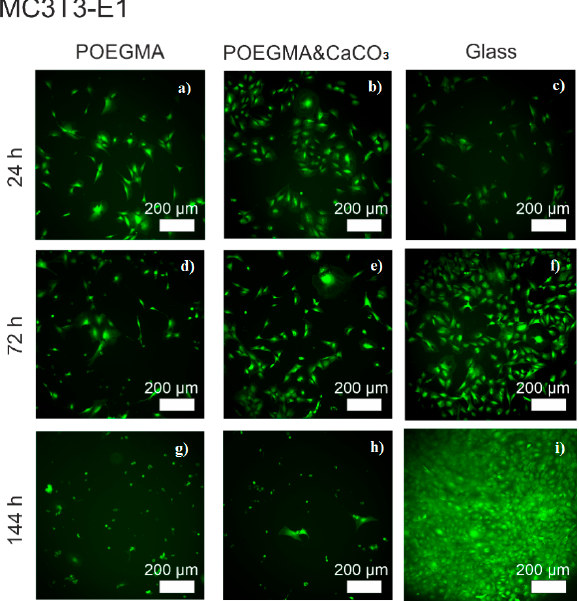
Figure 11. Fluorescence images of osteoblastic cell line MC3T3-e1 (Calcein AM) after 24 ( a – c ), 72 ( d – f ) and 144 h ( g – i ) of cultivation on glass surface ( c , f , i ), POEGMA ( a , d , g ) and POEGMA-grafted brush coatings with incorporated CaCO 3 NPs ( b , e , h ).